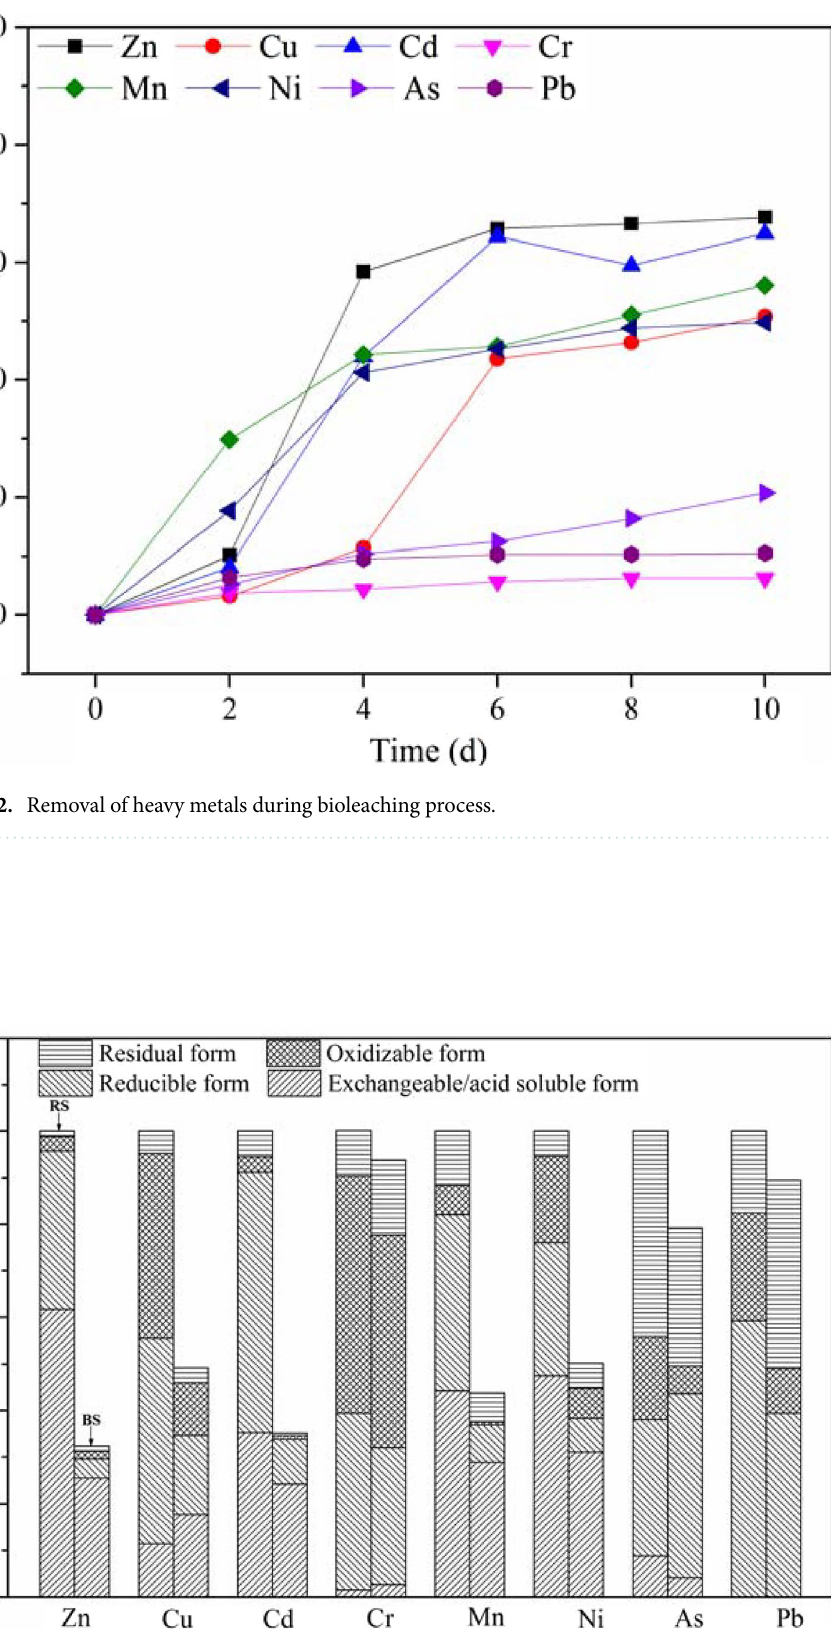
Figure 3. Chemical speciation distributions of heavy metals in raw sludge and bioleached sludge, total concentration of heavy metals in the raw sludge was set as 100% ( RS raw sludge, BS bioleached